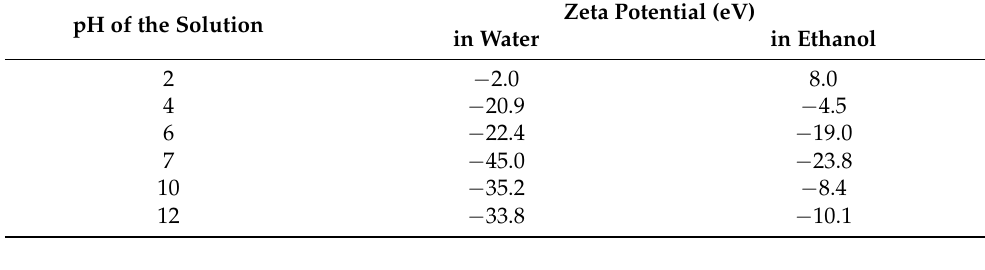
Table 2. The physiochemical properties of a colloidal solution of microstructures. pH of the Solution